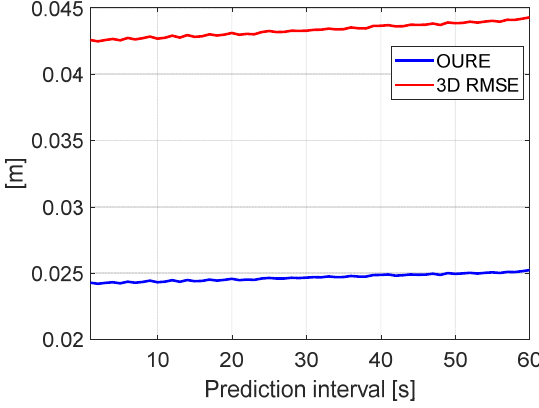
Figure 13. The OURE and the 3D RMSE of the predicted orbits for the short-term prediction.